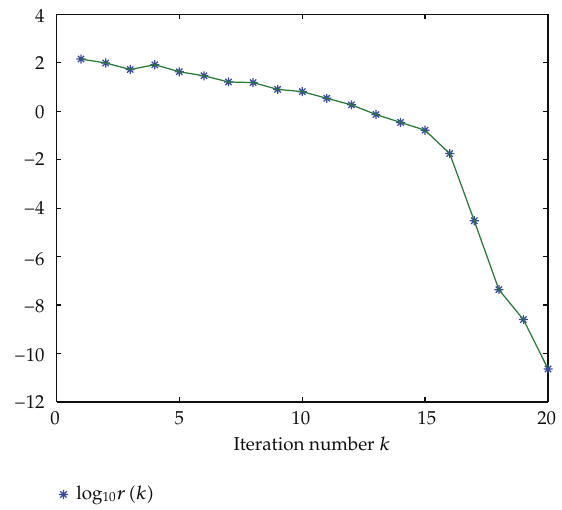
Figure 1: The convergence curve for the Frobenius norm of the residuals from Example 18.